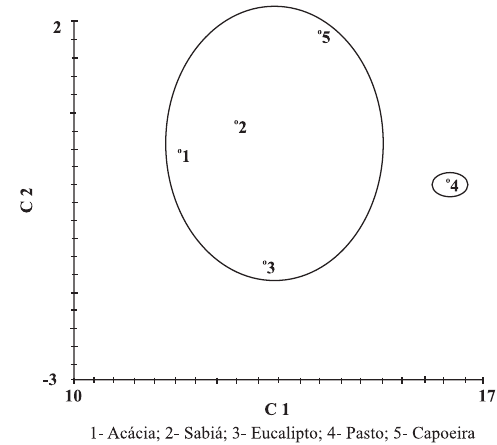
Figura 2. Dispersão gráfica das coberturas vegetais em relação aos dois primeiros componentes principais, com base nos teores de C orgânico, N total, CBM, NBM e C-CO dosolo sob diferentes 2 coberturas